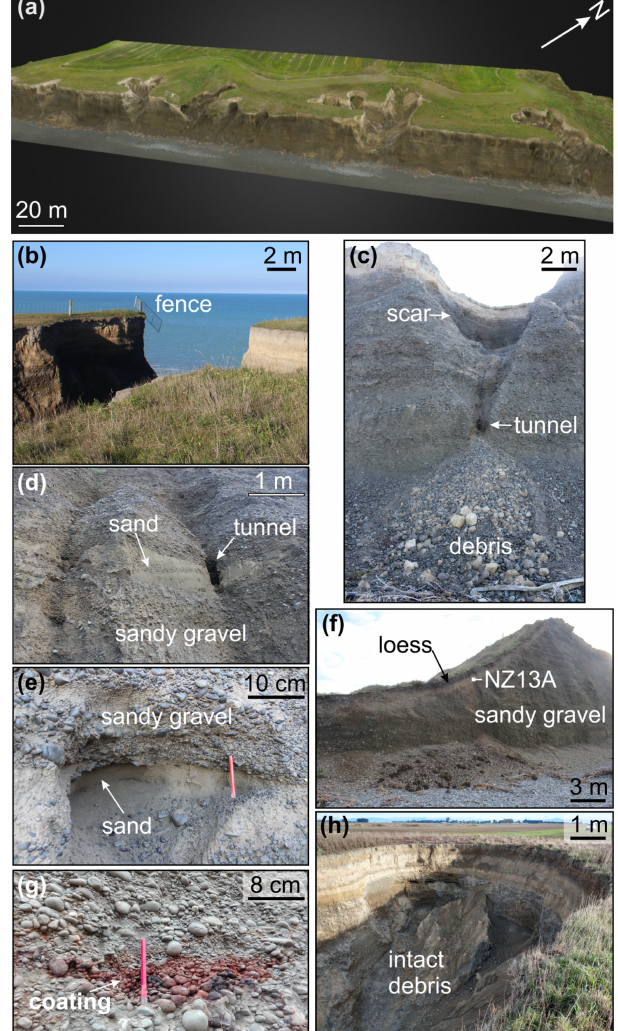
Figure 3. (a) Orthophoto map of part of the study area draped on a 3D digital elevation model. Location shown in Fig. 1b. (b–h) Pho- tographs of features of geomorphic interest taken at the study area. The location of sample NZ13A is shown in (f)